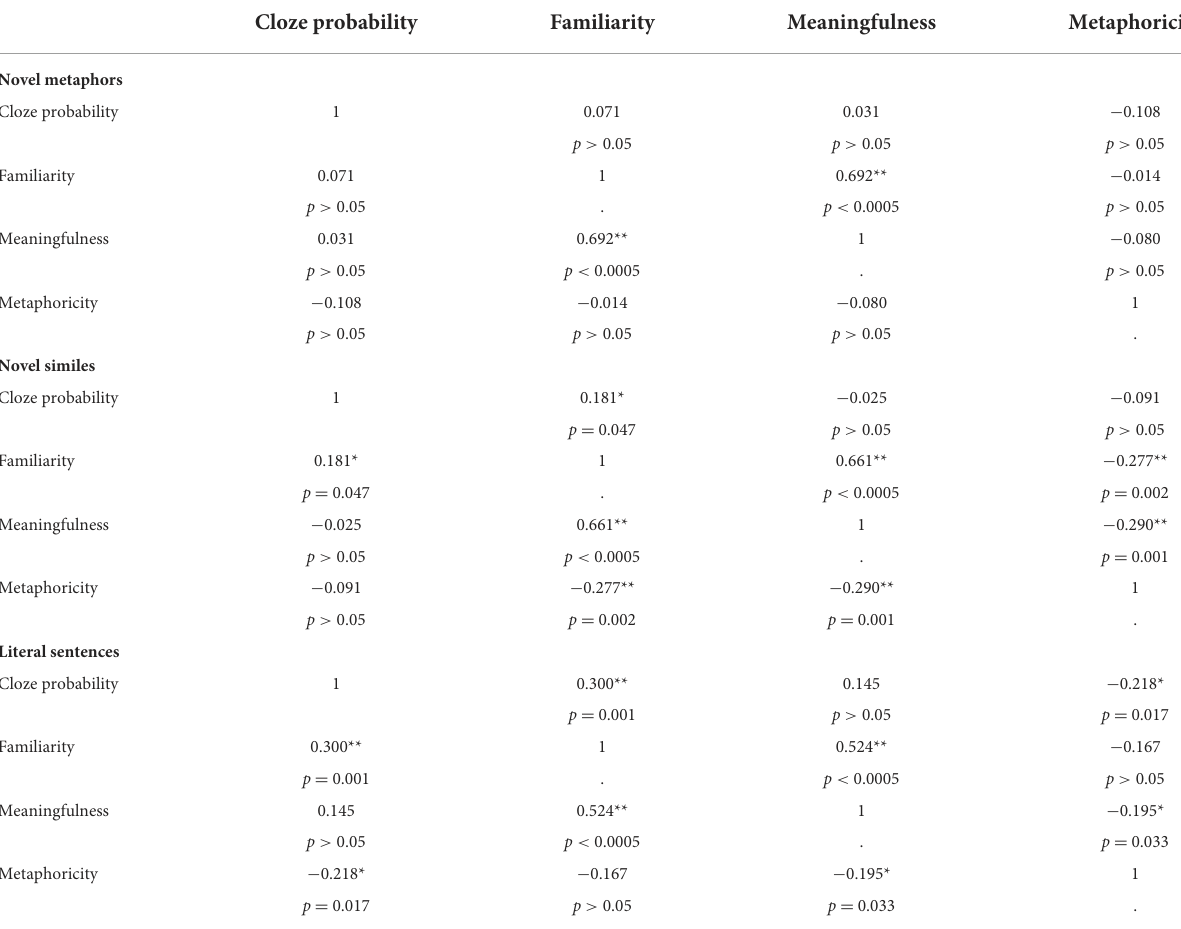
TABLE 2 Interscale correlations between cloze probability tests, familiarity, meaningfulness, and metaphoricity ratings. Cloze probability Familiarity Meaningfulness